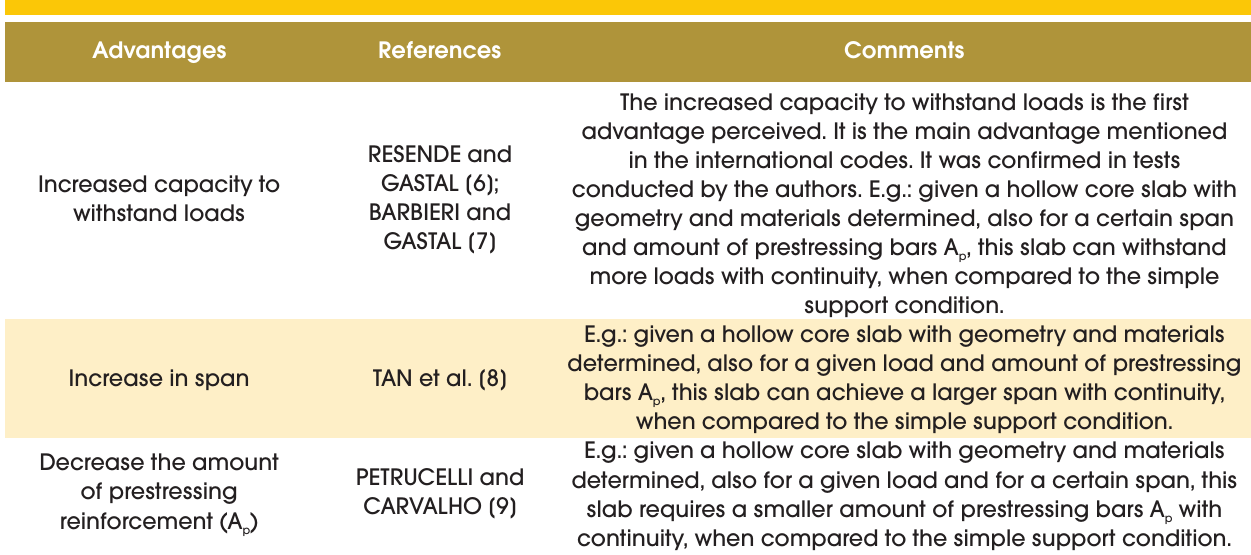
Table 1 – Advantages of using continuity. Comparison with the simply supported condition